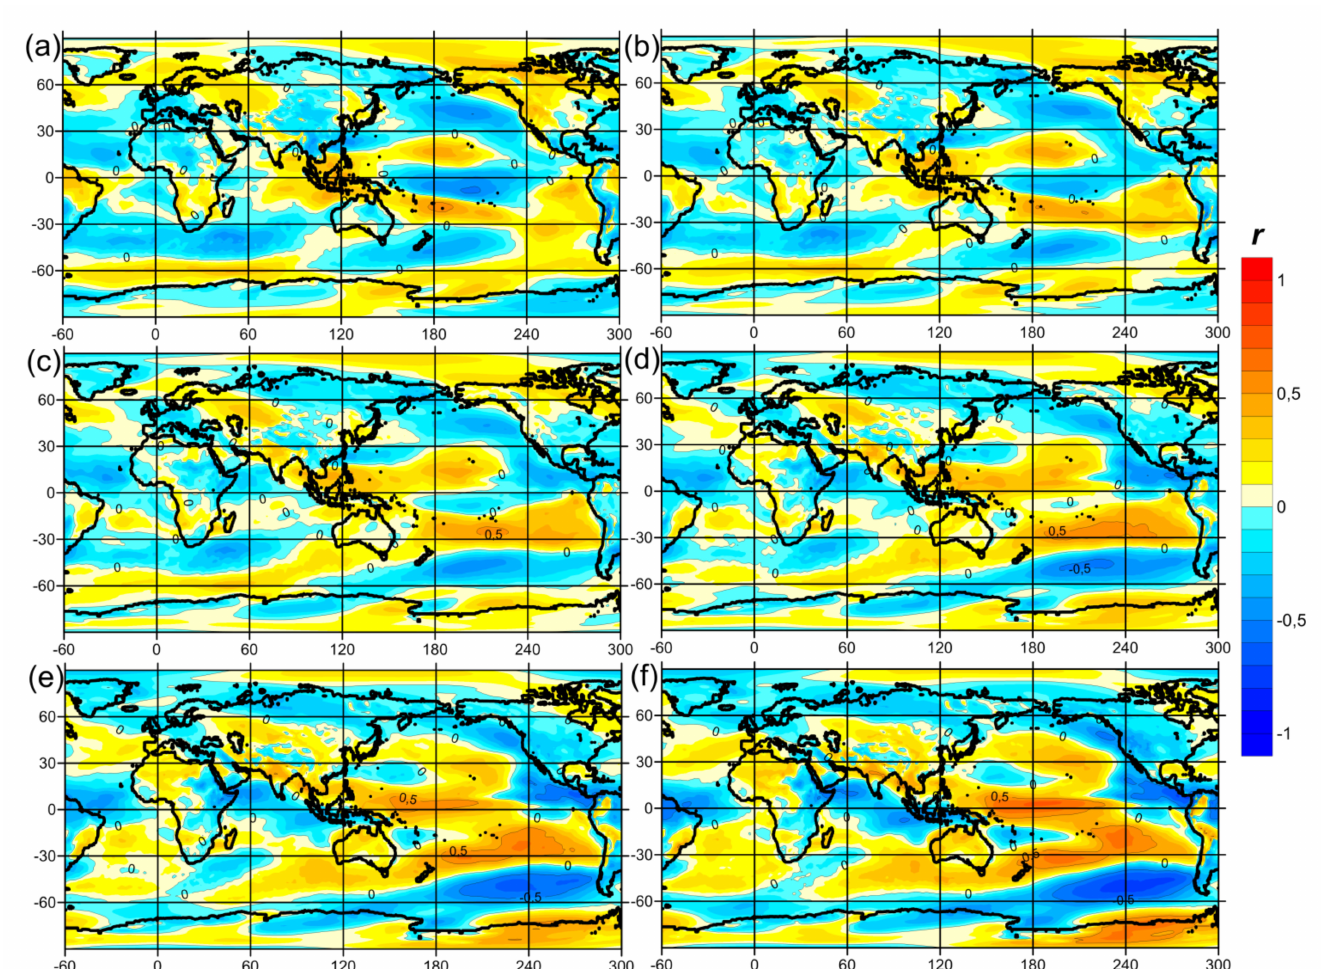
Figure 12. Cross-correlations between 14-month ( a ), 12-month ( b ), 10-month ( c ), 8-month ( d ), 6-month ( e ) and 4-month ( f ) shifts in anomalies of the zonal wind speed component at a height of 10 m from the surface and the Global Atmospheric Oscillation Index (GAO2) with band-pass filtering from 2 to 7